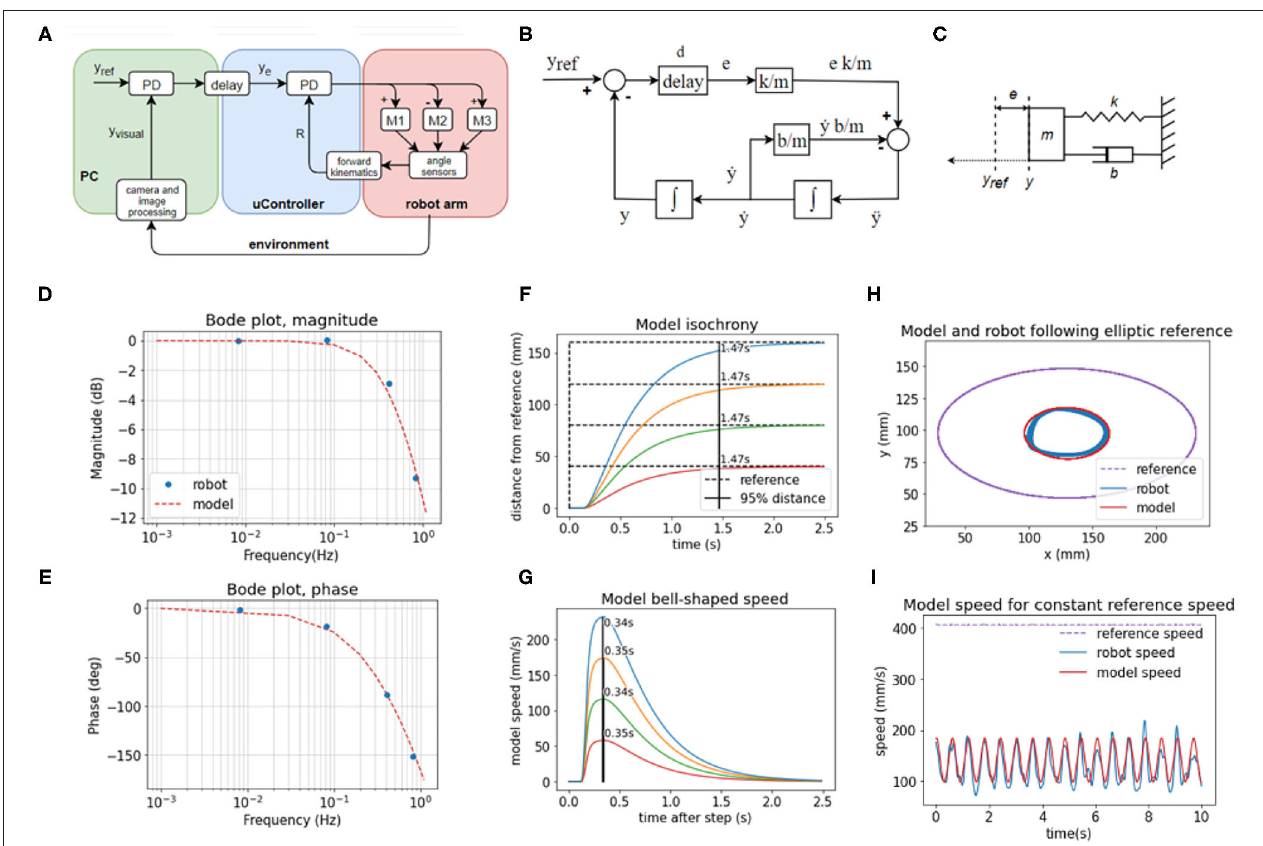
FIGURE 5 | The behavior of visual feedback loops can be represented by a second-order model. (A) Diagram of the elements in the control of the position of the hand in visual space in y dimension, including the lower-level control of reach distance. (B) Block diagram of the model with variables, parameters, and functions. (C) Free body diagram of a mechanical setup analogous to the model mass on a spring with damping. (D) Bode magnitude plot shows how the amplitude of output signals at high frequencies is attenuated in relation to the input signals. (E) Bode phase plot showing the frequency-dependent phase difference between the input and the output. The model reproduces the frequency-dependent properties of the robot’s visual loop. (F) The model produces a similar pattern of isochronous movement independent of distance in the step reference task; as well as (G) bell-shaped speed profiles in the same task (H) The model produces an ellipse smaller than the reference ellipse, similar to the robot, due to attenuation of high-frequency inputs. The frequency of the input here is 0.826Hz, and the attenuation is ∼ 9.5 dB. (I) In the same task, the speed of the model follows the same sinusoidal pattern as the speed of the robot, even with the constant speed of the reference. Model trajectory was not smoothed in any of the